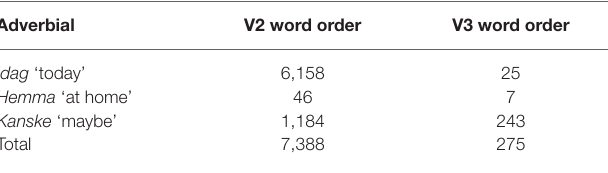
TABLE 1 | Incidence (raw frequencies) of V2/V3 word order in Bloggmix following sentence-initial adverbials. Adverbial V2 word